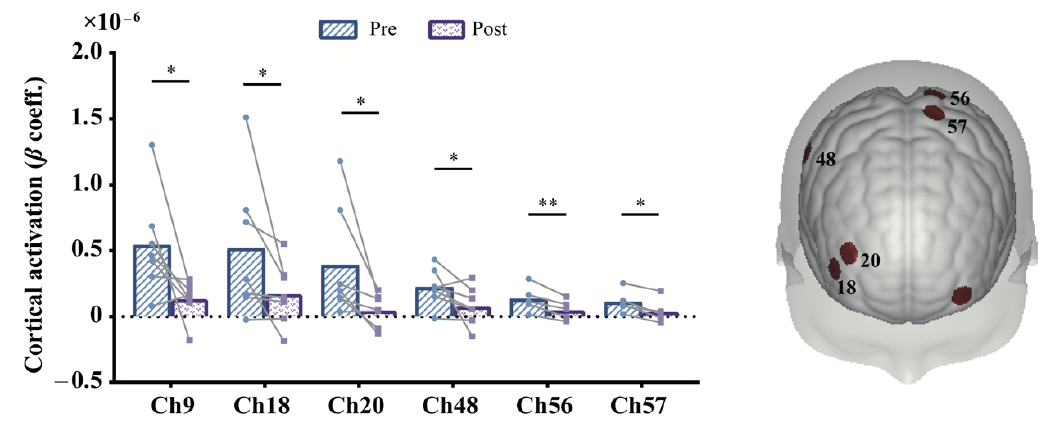
Figure 5. Contrast of post- and pre-prolonged mPES for HbO. The colored regions on the brain denote the locations of these channels. * p < 0.05, ** p < 0.01, uncorrected. Statistical results refer to Table 2. mPES modified pharyngeal electrical stimulation.